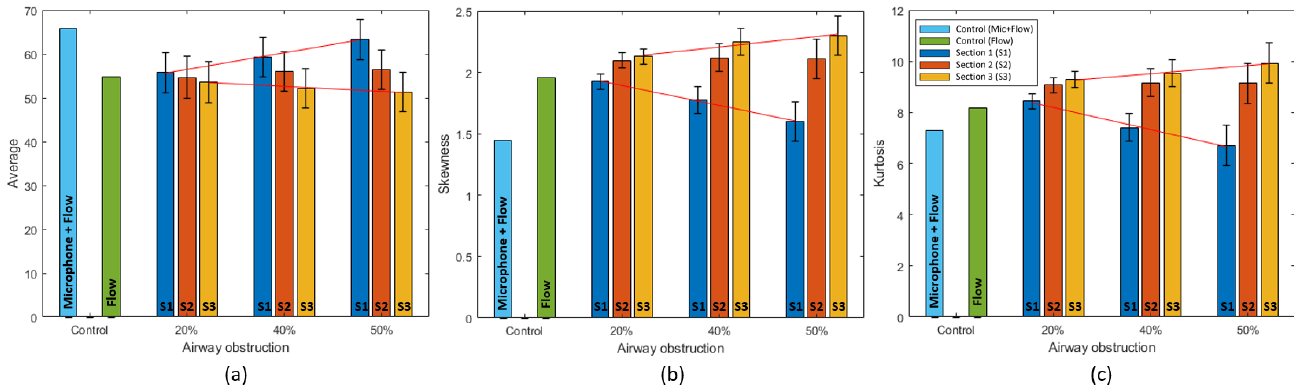
Figure 9. Texture analysis result graph for Phase C of flow and microphone + flow. ( a ) Average result graph, ( b ) skewness result graph, and ( c ) kurtosis result graph.